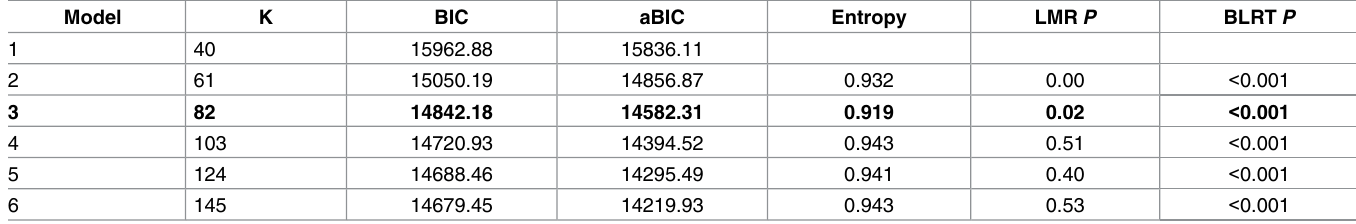
Table 2. Fit indices of each model.